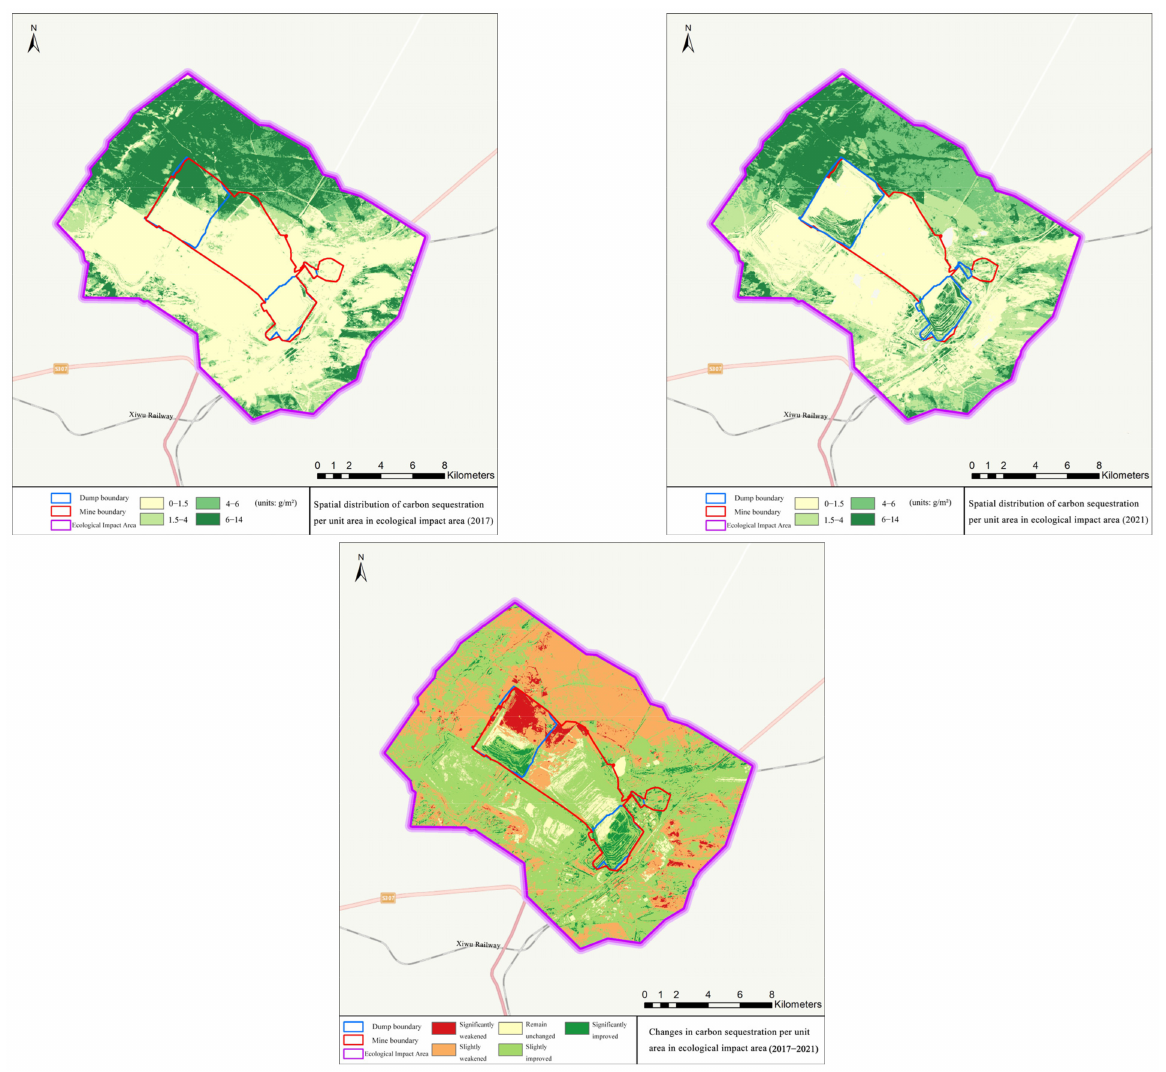
Figure 8. Changes of carbon sequestration effect in the ecological impact area before and after the implementation of ecological restoration